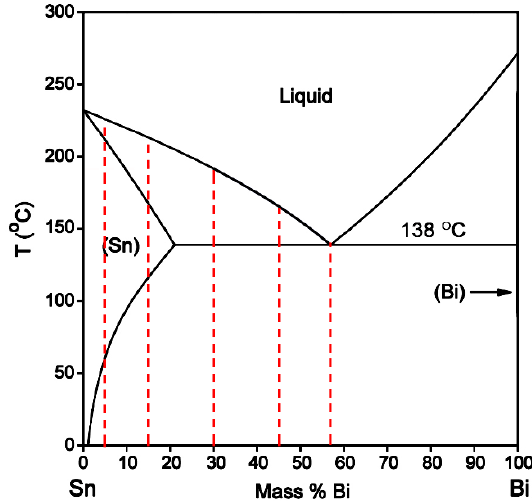
Figure 1. Sn-Bi Phase diagram [10] with dash lines illustrating the concentrations used in this study.